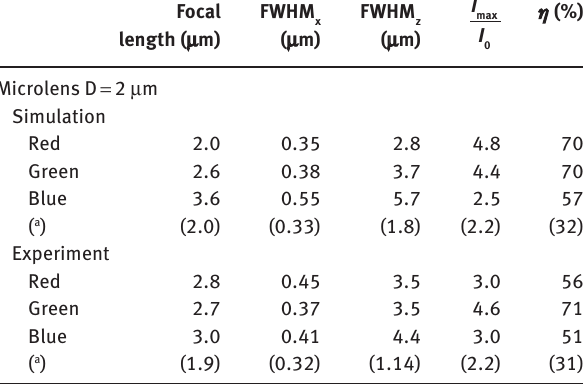
along the focal axis are shown in SI. Figure 10. For green color, the focusing occurs at about 1.7 μ m with resolutions